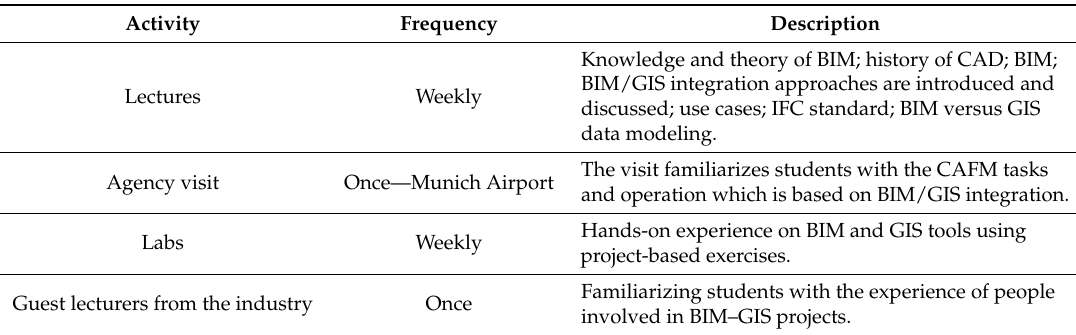
Table 2. Teaching and learning